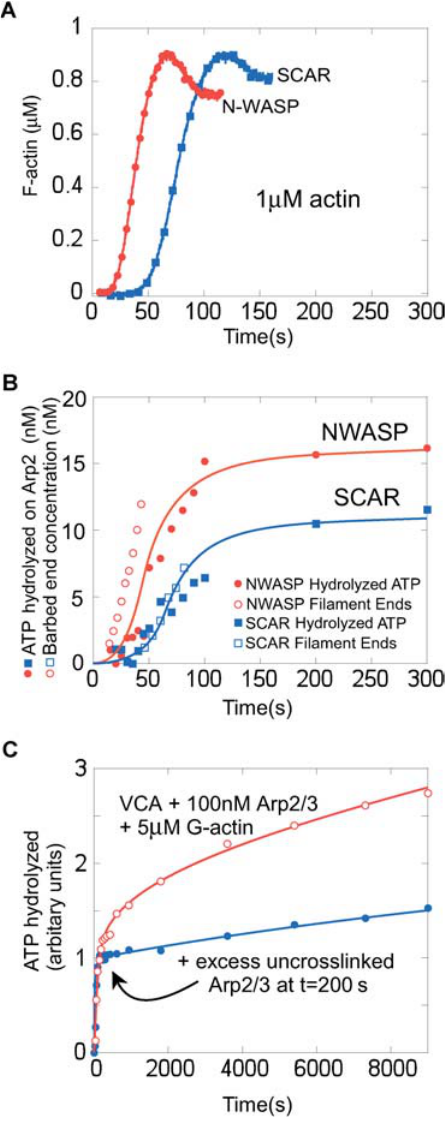
Figure 2. ATP Hydrolysis by Arp2 Coincides with Nucleation of New Actin Filaments, and Not Filament Debranching (A, B) The kinetics of nucleation were slowed by using only 1 l M monomeric actin (compared to 2 l M for Figure 1). c - 32 P-AzidoATP- Arp2/3 (20 nM) was mixed with either 750 nM N-WASP WWA (closed circle) or Scar1 WA (closed square) and 1 l M 7% pyrene-labeled monomeric actin. (A) Actin polymerization measured by pyrene fluorescence. (B) The concentration of new filament ends (open symbols) was calculated from the polymerization data in a model-independent way (see Methods and Materials), and Arp2-ATP hydrolysis (closed symbols) was measured under the same reaction conditions for both N-WASP WWA (open and closed circles) and Scar1 WA (open and closed squares). (C) ATP hydrolysis on Arp2 does not accompany filament debranch- ing. Using a large excess (100 nM) of c - 32 P-AzidoATP-Arp2/3 creates a slow hydrolysis phase that follows the rapid nucleation phase. The slow phase of ATP hydrolysis can be inhibited by excess (1.5 l M) uncrosslinked Arp2/3 added at t = 200 s, showing that the slow phase of ATP hydrolysis is from Arp2/3 being recruited from solution and not from that already incorporated in branches. DOI: 10.1371/journal.pbio.0020091.g002